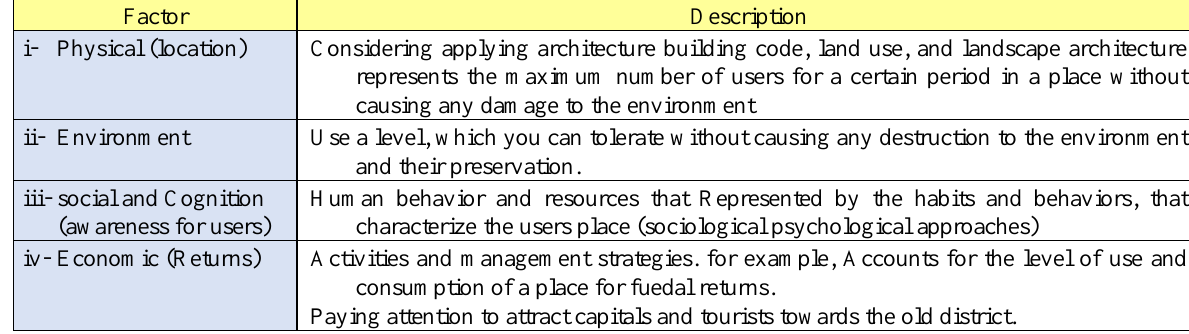
Table 2. Influences with phenomena of Visual pollution in Manama Old districts